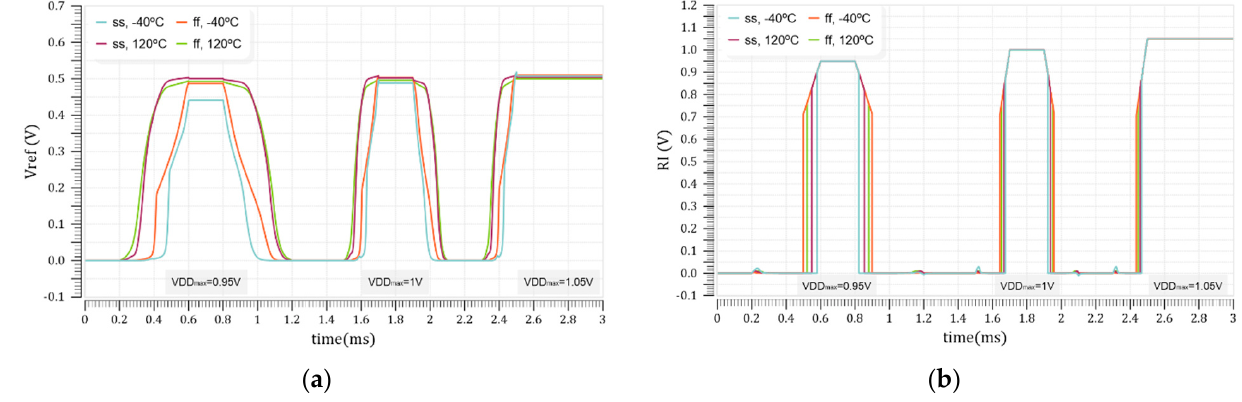
Figure 11. Simulation results for BGR#2 (65 nm, 1 V) in PVT corners. ( a ) Vref , ( b ) RI.